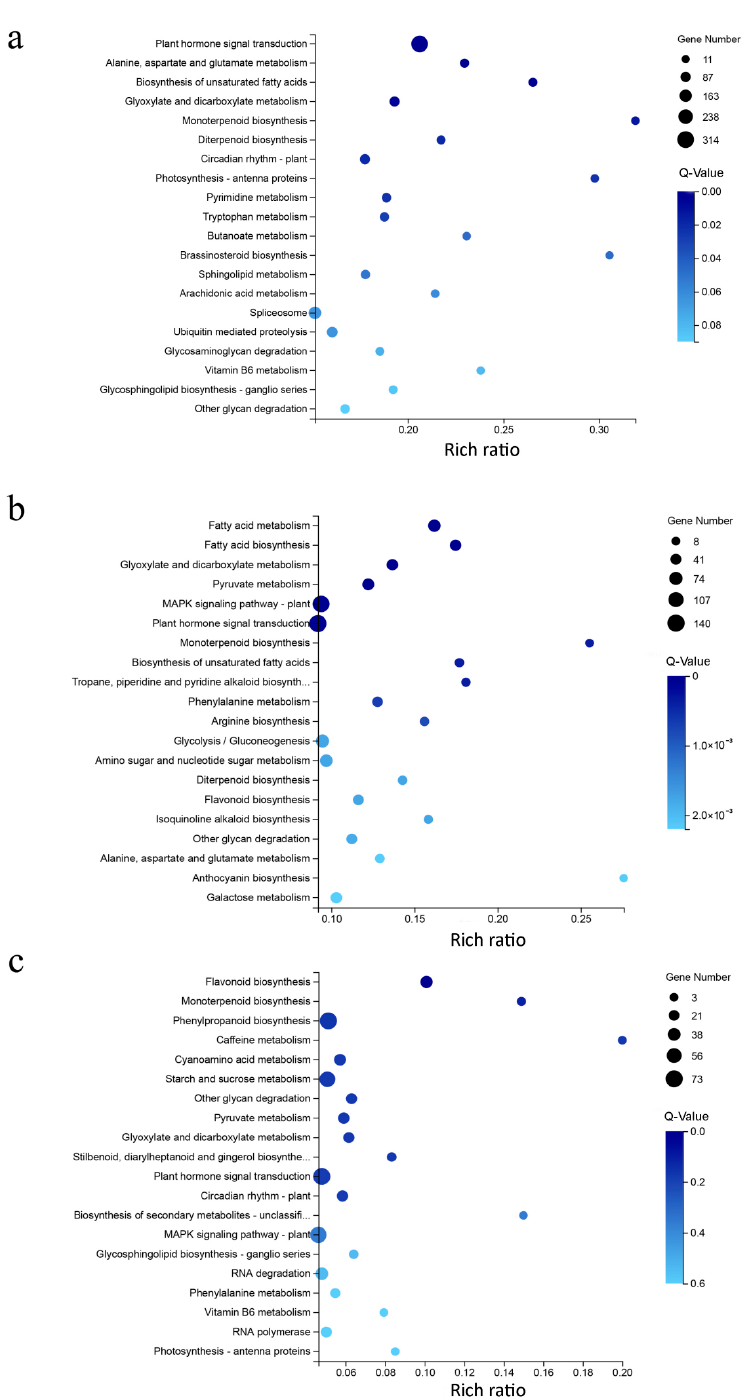
Figure 6. Bubble diagram of top 20 enriched KEGG pathways of DEGs in seeds of ssm1 and LH11 at three stages. ( a ) DAP10; ( b ) DAP20; ( c ) DAP40. X -axis represents the rich ratio, which means the ratio of selected gene number annotated to a particular item to the total number of genes in this item in one species. The calculating formula is Rich Ratio = Term Candidate Gene Num/Term Gene Num. Y -axis represents KEGG Pathway. The size of the bubbles indicates the number of genes annotated to a KEGG Pathway. The color represents Q-value of enrichment. The deeper the color, the smaller the